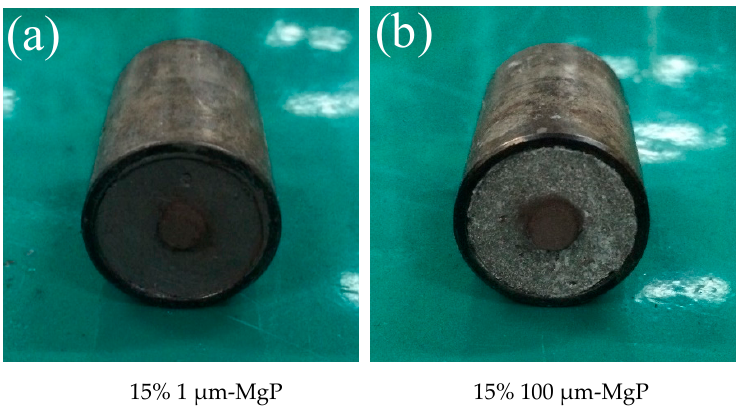
Figure 10. Combustion test samples of small ( a ) and large ( b ) magnesium particles/paraffin composite fuels.